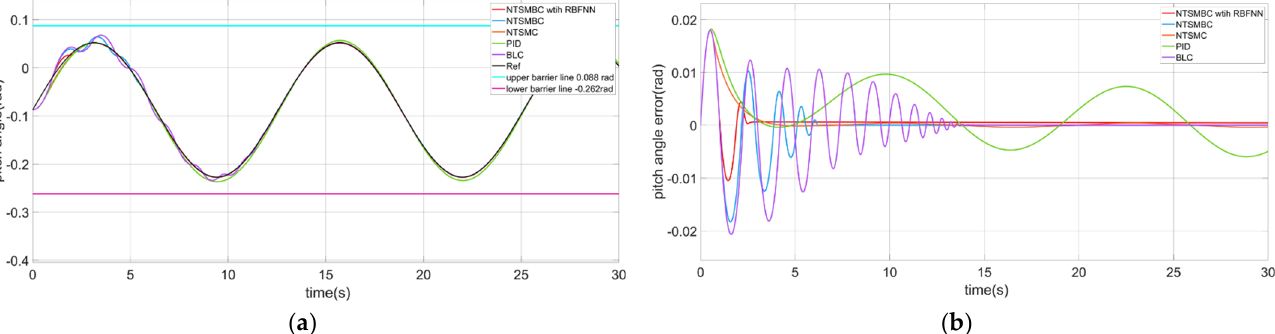
Figure 10. The pitch angle control. ( a ) The pitch angle control results of the four control methods without the random lumped disturbance. ( b ) The pitch angle control errors without the random lumped disturbance.